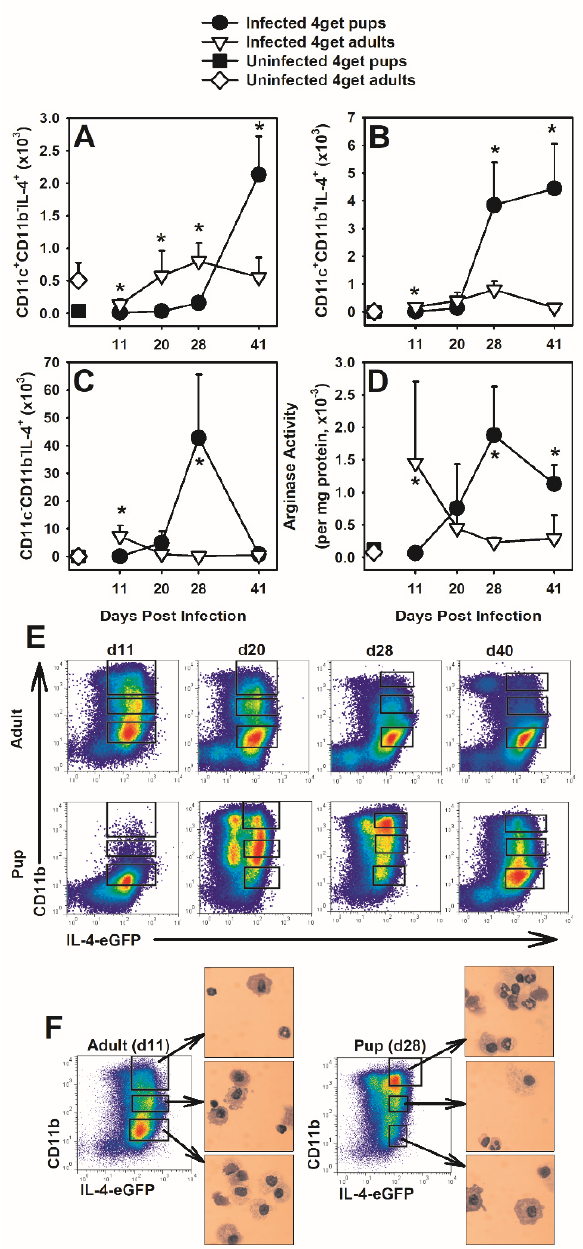
Figure 2. Myeloid cells from BALF of neonates and adults produce IL-4 in response to P. murina infection. 4get pups (2-day-old) and adults ( ≥ 8 weeks) were infected with 5 × 10 5 PC organisms/g of body weight. At indicated days post infection, BALF was collected and processed from 4–6 mice per group as described in materials and methods for flow cytometry analysis ( A – C ) or sorting of IL-4 expressing cells ( E , F ). ( A – C ) BAL cells were stained with antibody against CD11c and CD11b and analyzed by flow cytometry. CD11c + CD11b - cells are considered to be resident AMs and CD11c + CD11b + are considered to be activated macrophages. ( D ) Lung digest lysates were used to determine arginase activity within the lung. ( E , F ) BALF cells were stained with antibody against CD11b and sorted based on IL-4 expression and high, intermediate, or low expression of CD11b. Sorted cells were spun onto glass slides and analyzed microscopically based on morphologic characteristics. Data represent the means ± SD and are representative of 2 independent experiments. Mann–Whitney rank sum tests were used to compare data at each individual time point. * p ≤ 0.05, comparing P. murina infected 4get neonates to P. murina infected 4get